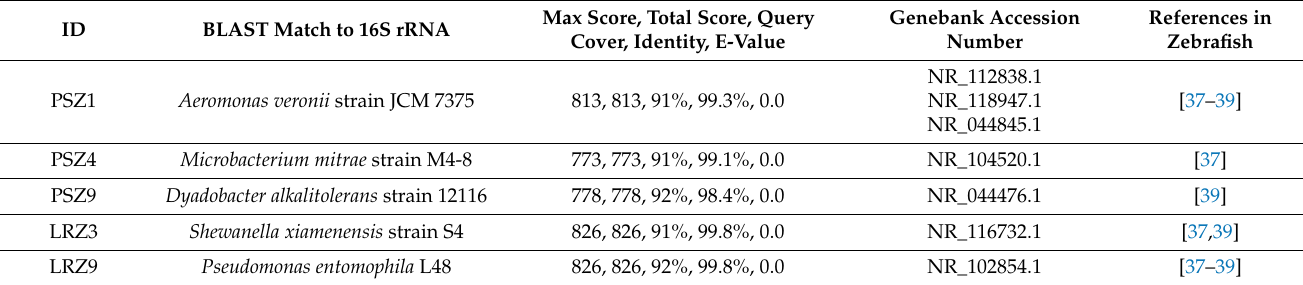
Table 2. BLAST results of 16S rRNA gene sequences from aerobic bacterial type I colony